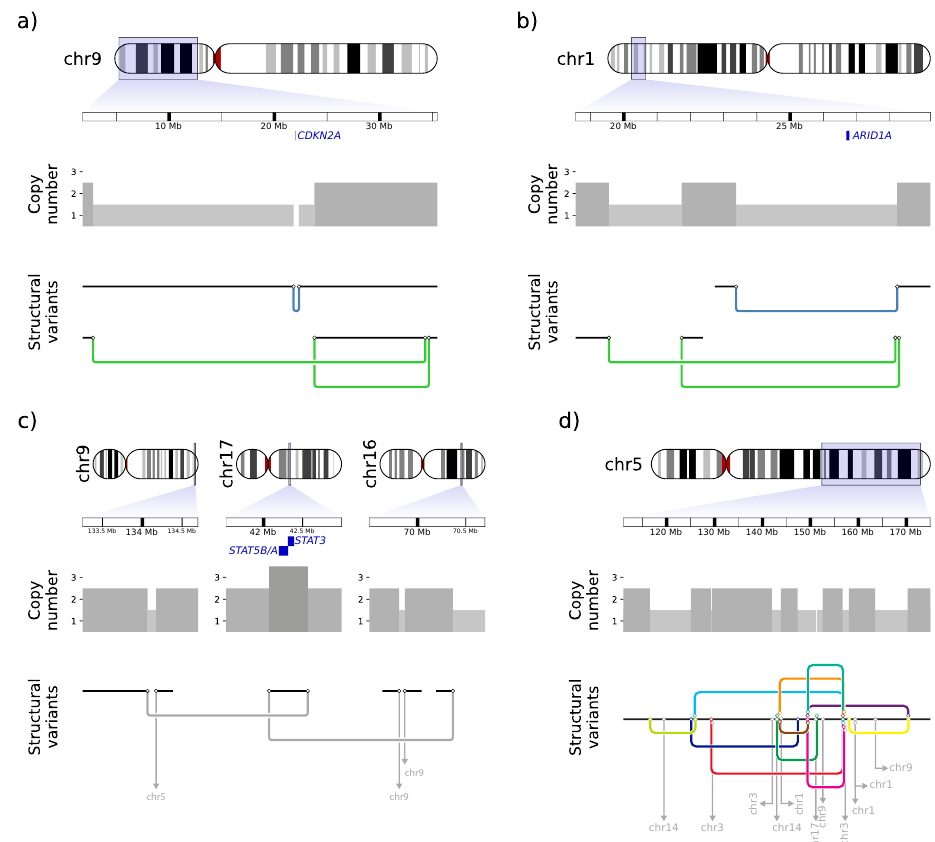
Figure 4. Deletion of CDKN2A and ARID1A , amplification of STAT5 by templated insertion SVs and complex rearrangement of chromosome 5. Each panel consists of three parts (top to bottom): The genome position of the respective section with marked position of the gene of interest (blue), the copy-number, and the detected SVs. SVs consist of two breakpoints (black circles) connected by a junction, colored dependent on the type of SV (deletion: blue, inversion: green, translocation: gray). Translocations where only one breakpoint is visible are shown as gray arrows and the chromosomal fusion partner is annotated. Chromosomal segments joined by SVs are depicted by black lines. ( a ) Homozygous deletion of CDKN2A by two SVs in cis : one small deletion and one bridge of templated insertion SV, where chr9: 23.8–34.4 Mb is inserted inversely in a chr9: 2.8–34.5 Mb deletion. ( b ) Heterozygous deletion of ARID1A and an adjacent bridge of templated insertion SV with an insertion of a 2.8 kb segment only 639 bp distant to one ARID1A deletion breakpoint. For this SV, single reads spanning both breakpoints as well as the complete inserted region are found.